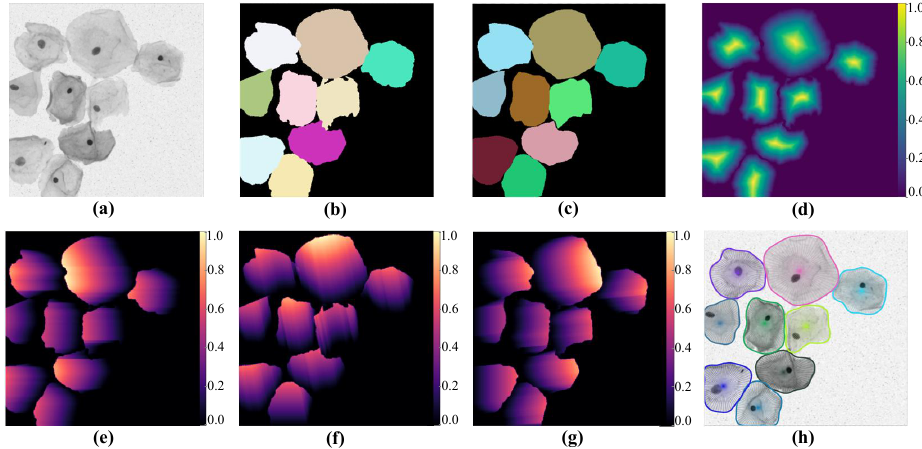
Figure 2. Intermediate results generated by our method. ( a ) An original image and ( b ) its corre- sponding label. ( c ) The star-convex polygon-based label and ( d ) the object probability map. ( e – g ) The normalized Euclidean distance maps for different directions, and ( h ) the final segmentation